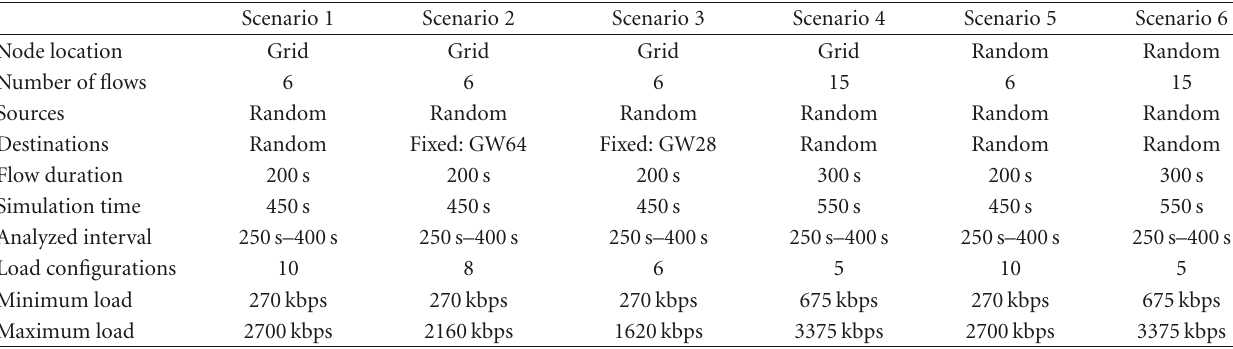
Table 5: Routing metrics performance: